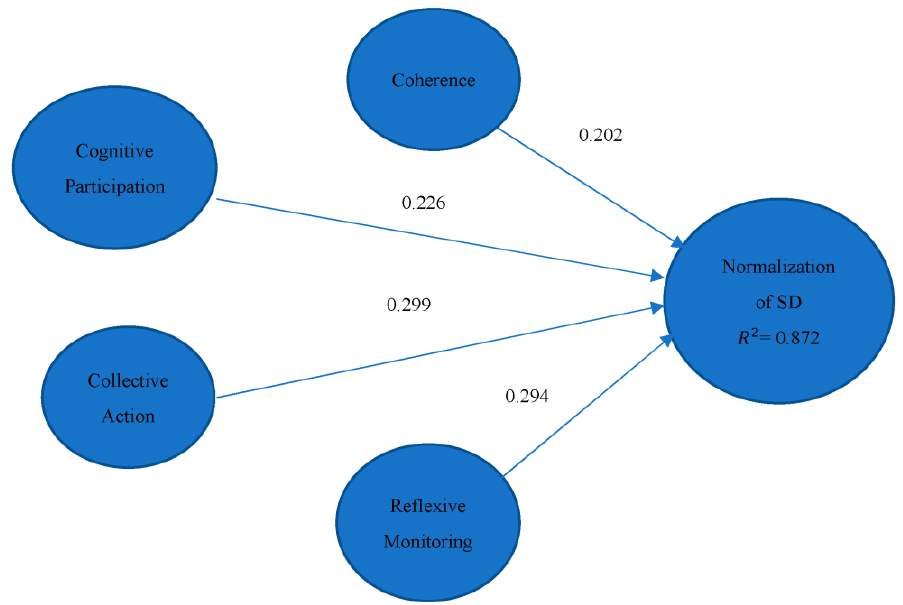
Figure 10. Structural model relationship.